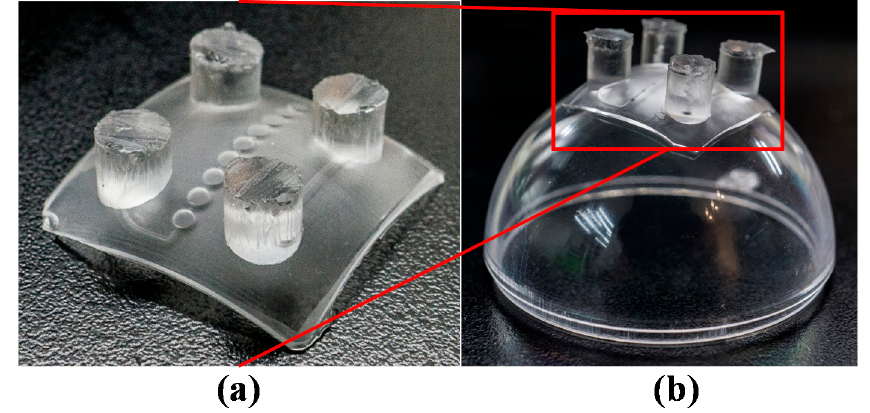
Figure 7. ( a ) Nonplanar ‐ cast PDMS membrane; ( b ) PDMS membrane bonded on a hemispherical PMMA substrate.